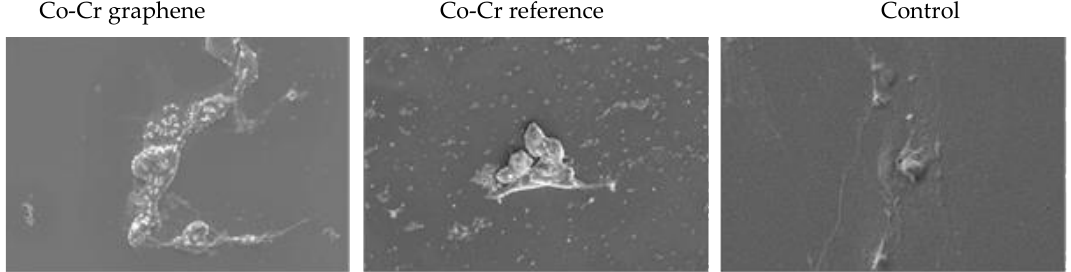
Figure 14. Evaluation of direct contact of BALB/3T3 mouse fibroblast cells with the examined discs. Co-Cr disks are visible as a dark semi-circle in the lower left corner, negative control high-density polyethylene (HDPE) of cells without Co-Cr disks. Magnification 50×.